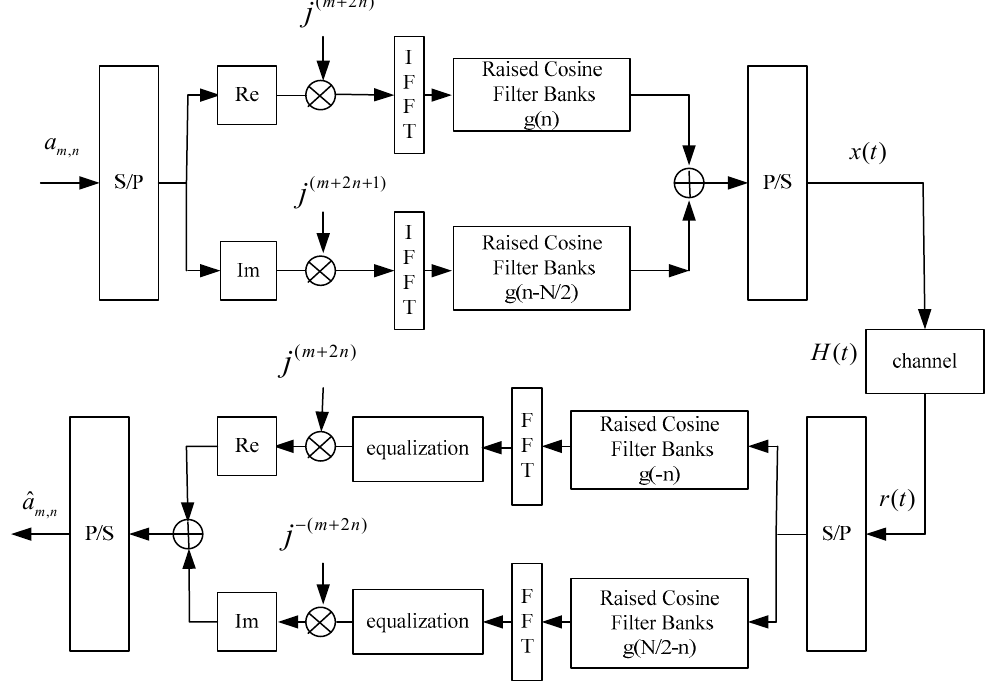
Figure 1. The IFFT/FFT implementation diagram of the FBMC/OQAM system.